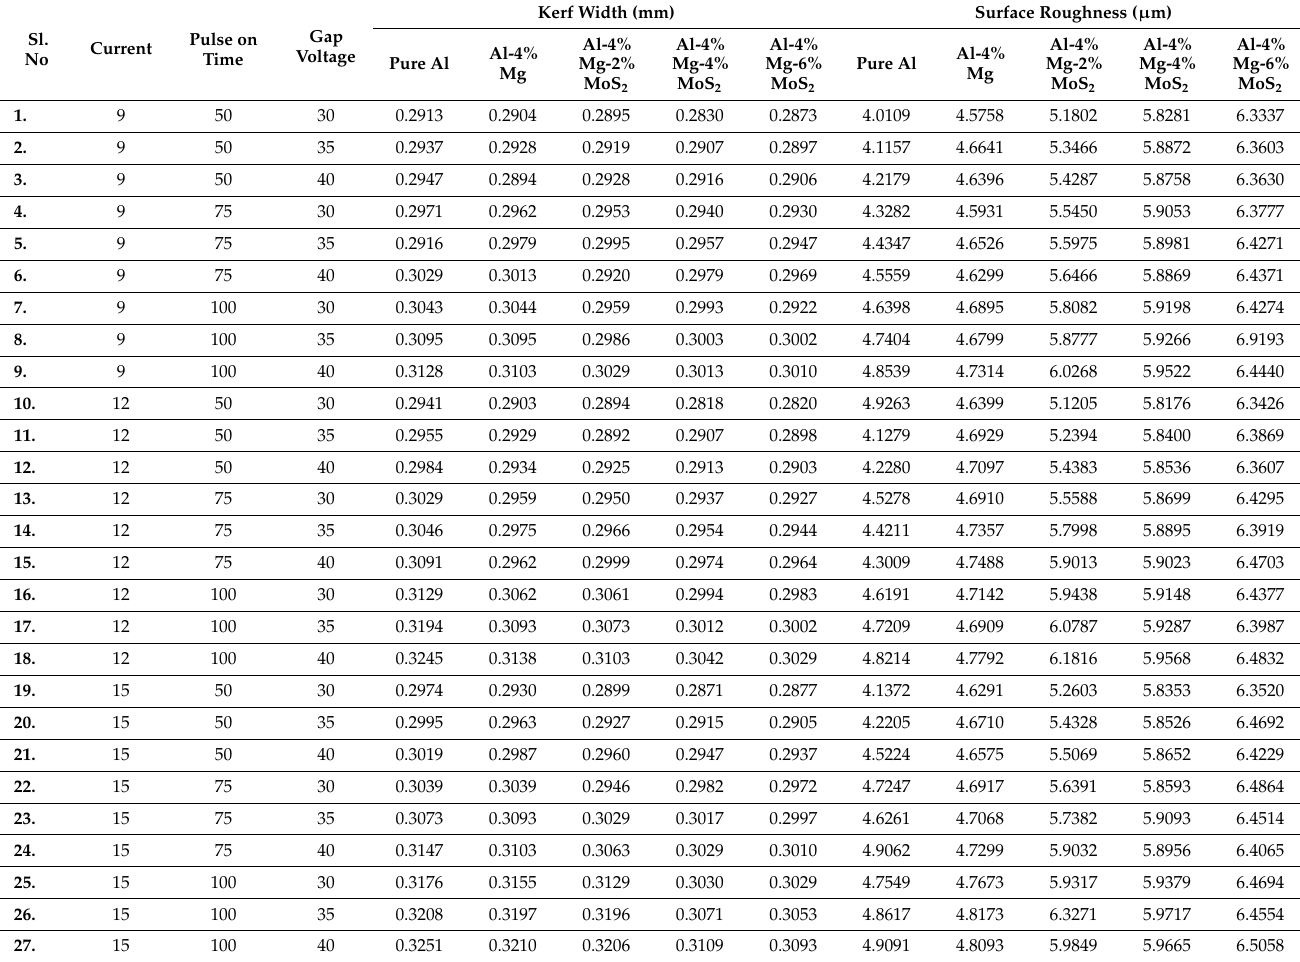
Table 2. Experimental Results of WEDM